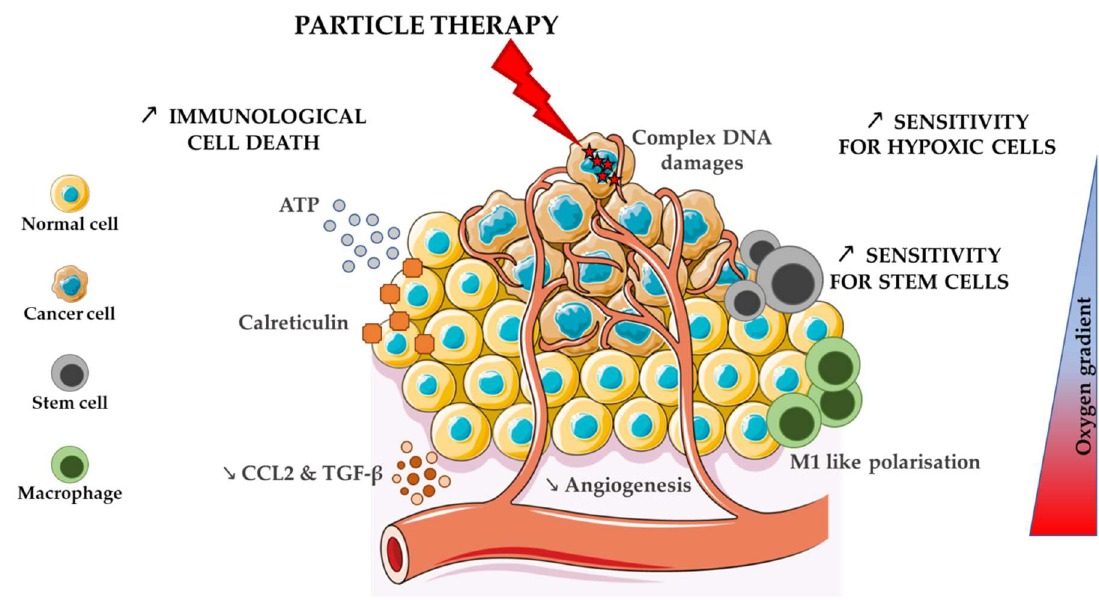
Figure 1. Attractive effects of charged particles in comparison to photons on the different tumour cell